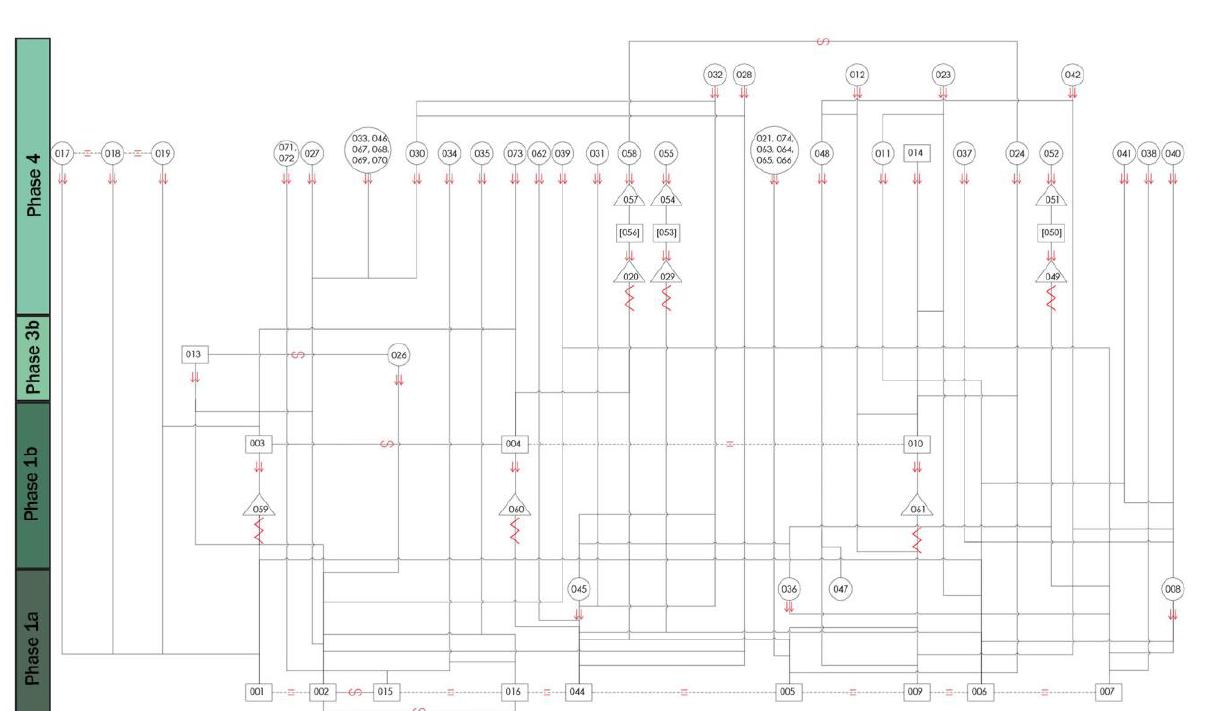
Figure 4. a) Stratigraphic analysis of a masonry; b) Harry’s diagram with the relative chronology (the stratigraphic analysis has been carried out in collaboration with the Masterclass in Architectural Restoration a.a.2017-2018, prof. Fiorino D.R., tutor Pilia E. (graphic elab.: Loi